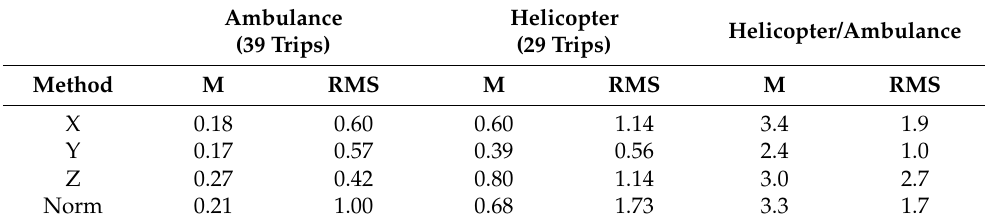
Table 2. Vibration levels in ambulance, helicopter, and ratio between the two vehicles.